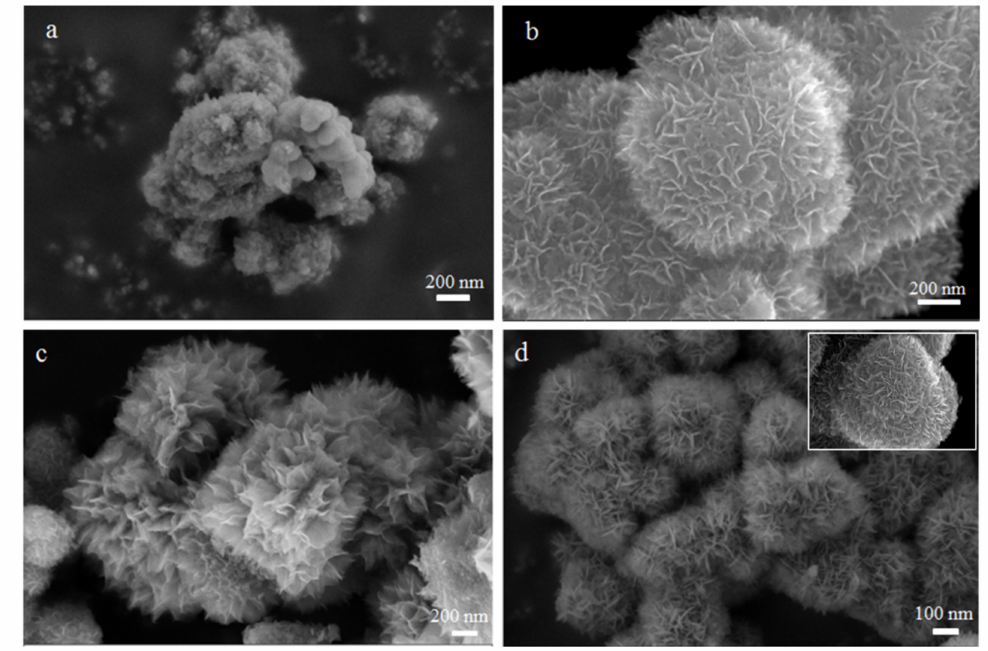
Figure 2. SEM images showing the morphological evolution of the obtained samples prepared from different solvothermal reaction time: ( a ) 0.5 h; ( b ) 2 h; ( c ) 6 h and ( d ) 10